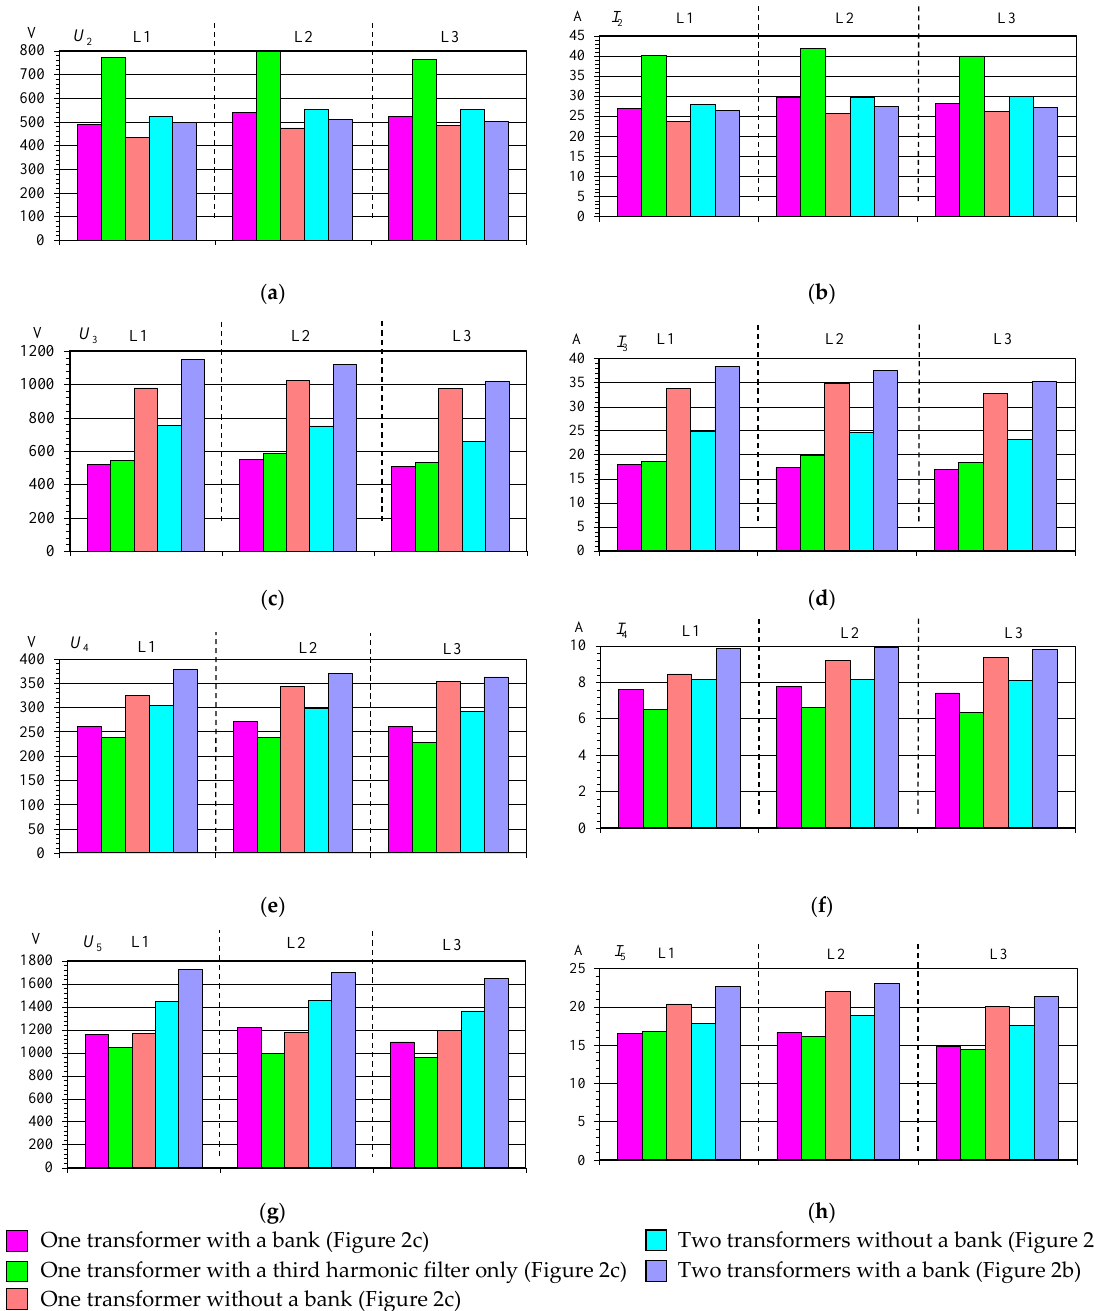
One transformer with a bank (Figure 2c) Two transformers without a bank (Figure 2b) One transformer with a third harmonic filter only (Figure 2c) Two transformers with a bank (Figure 2b) One transformer without a bank (Figure 2c) Figure 10. Arithmetic means of 500 maximum RMS values from all three phases. ( a ) Second harmonic voltages. ( b ) Second harmonic currents. ( c ) Third harmonic voltages. ( d ) Third harmonic currents. ( e ) Fourth harmonic voltages. ( f ) Fourth harmonic currents. ( g ) Fifth harmonic voltages. ( h ) Fifth harmonic currents.